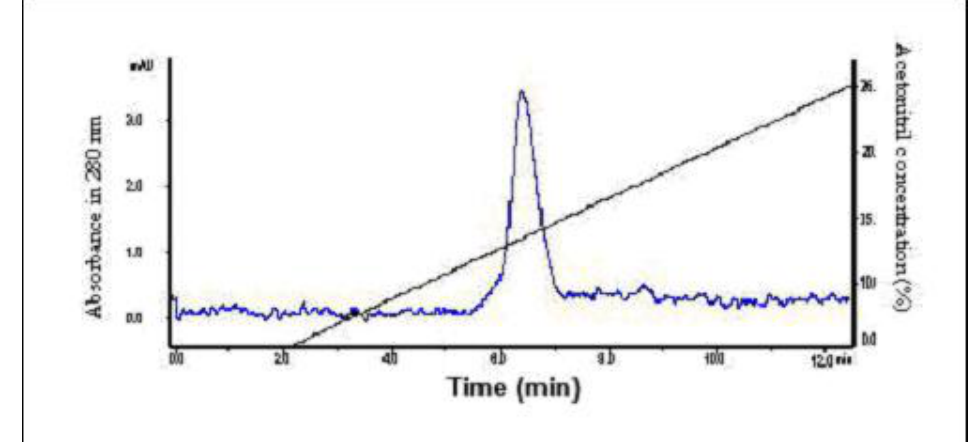
Figure 4. Purity assay of AH143 by